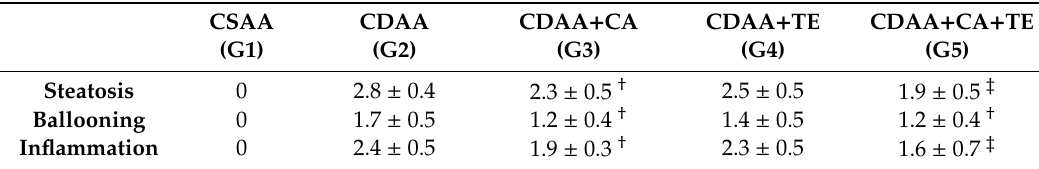
Figure 10. Representative images of hematoxylin – eosin-stained liver sections of different experimental groups (original magnification ×40). G1, Group 1 (choline-sufficient, L-amino acid-defined diet); G2, Group 2 (choline-deficient, L-amino acid-defined diet (CDAA)); G3, Group 3 (CDAA+ canagliflozin (CA)); G4, Group 4 (CDAA+ teneligliptin (TE)); G5, Group 5 (CDAA+CA+TE). Table 2. Non-alcoholic fatty liver disease activity score in experimental groups in a non-diabetic rat model of